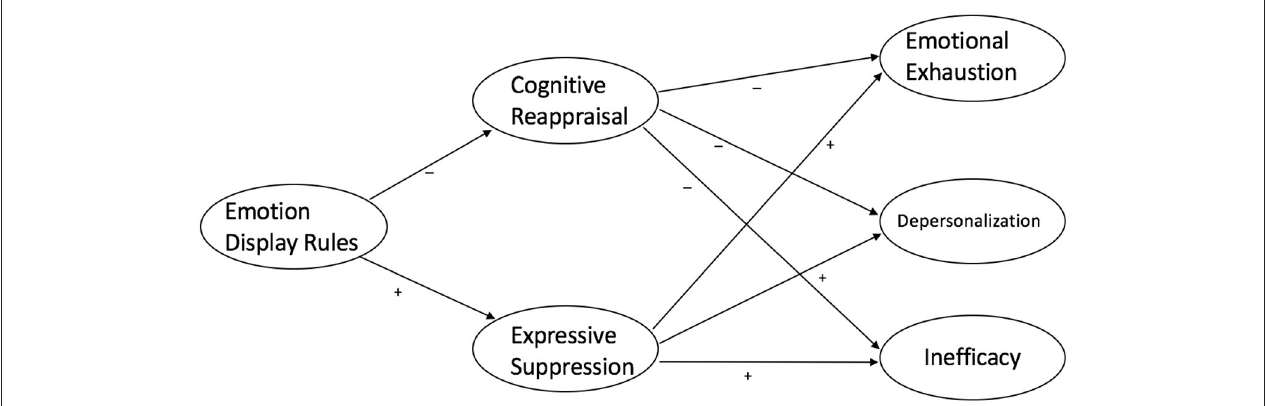
FIGURE 1 | Theoretical model. “ + ” indicates positive covariance predicted between the variables, “-” indicates negative covariance predicted between the variables.